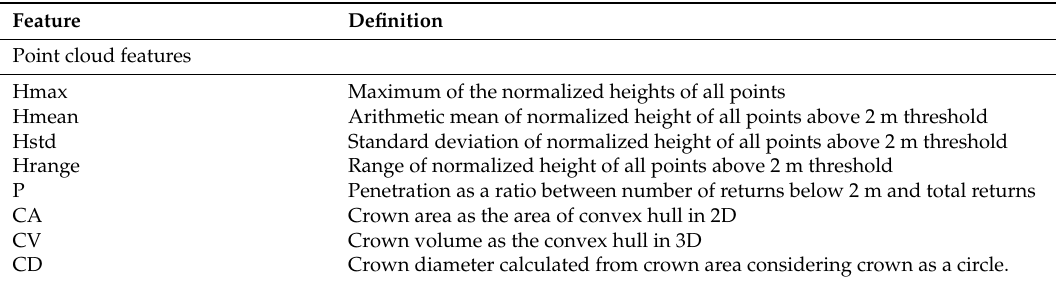
Table 3. Tree features derived from normalized point data and spectral information. (superscript i = 1, 2, and 3 for channel 1, 2, and